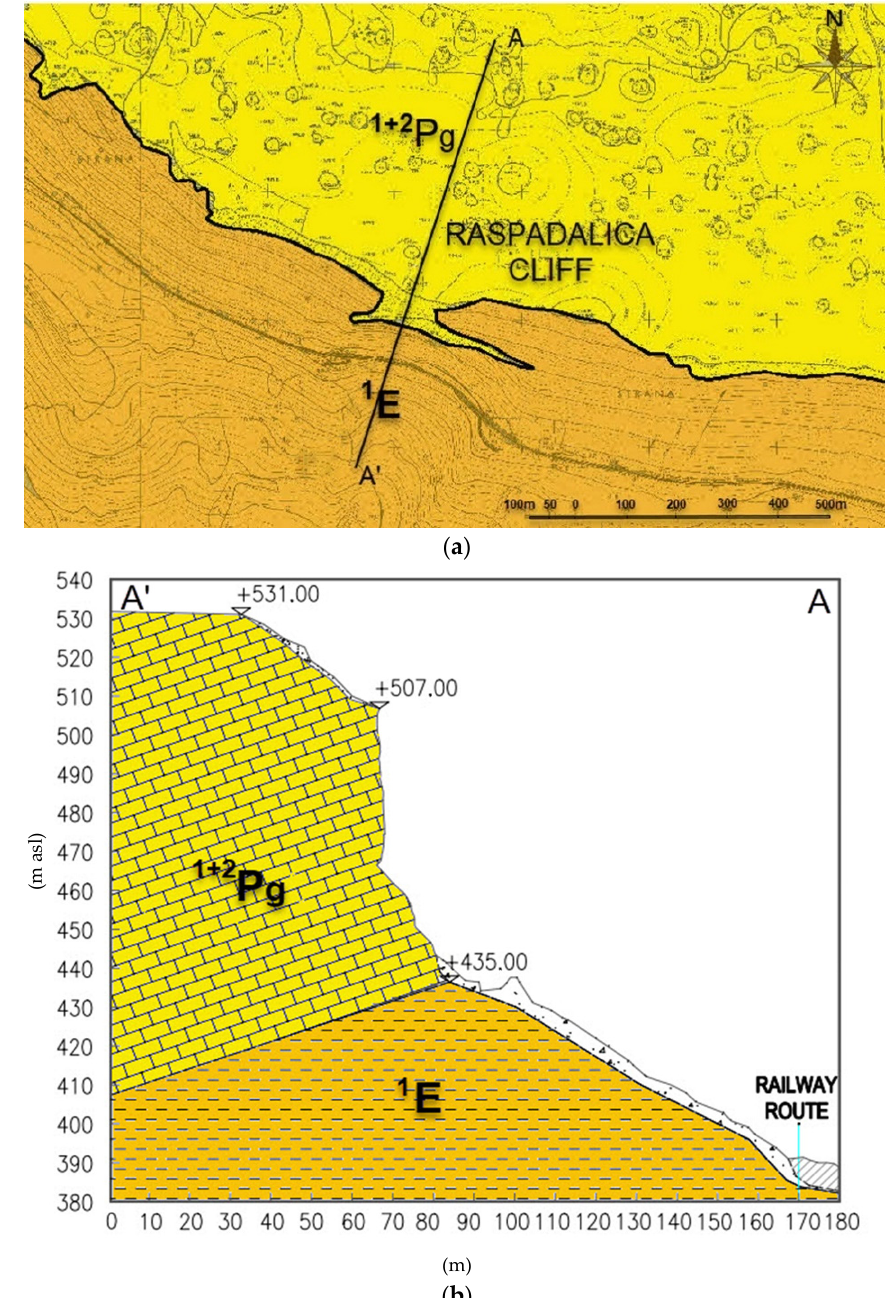
Figure 4. Geological map of the Raspadalica Cliff ( a ) and marked schematic cross-section (A–A’): ( b ). Overthrust limestone Lower and Middle Paleogene rock mass ( 1+2 Pg) lies on Lower Eocene flysch deposits ( 1 E). The flysch deposits are covered with talus material originating from a limestone cliff [12].